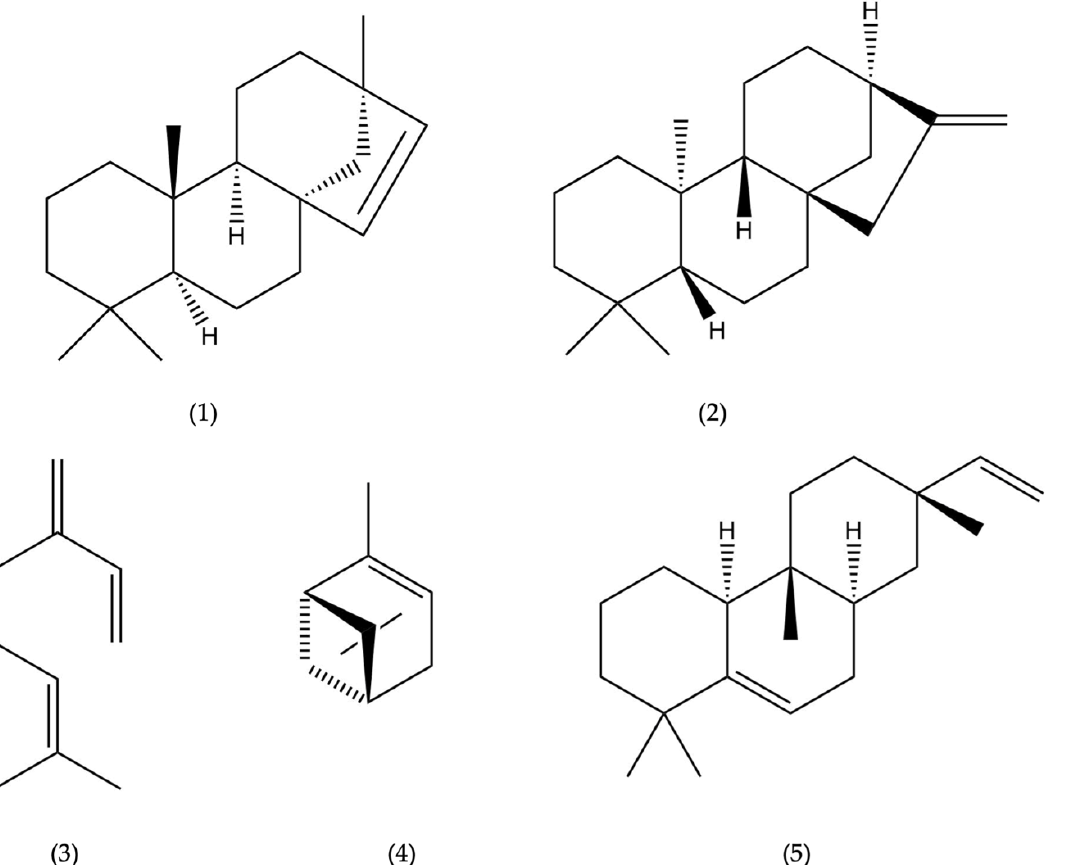
Figure 3. Chemical structures of the main compounds of the leaf essential oil of A. brasiliensis : beyerene ( 1 ), kaurene ( 2 ), myrcene ( 3 ), α -pinene ( 4 ) and rosa-5,15-diene ( 5 ).